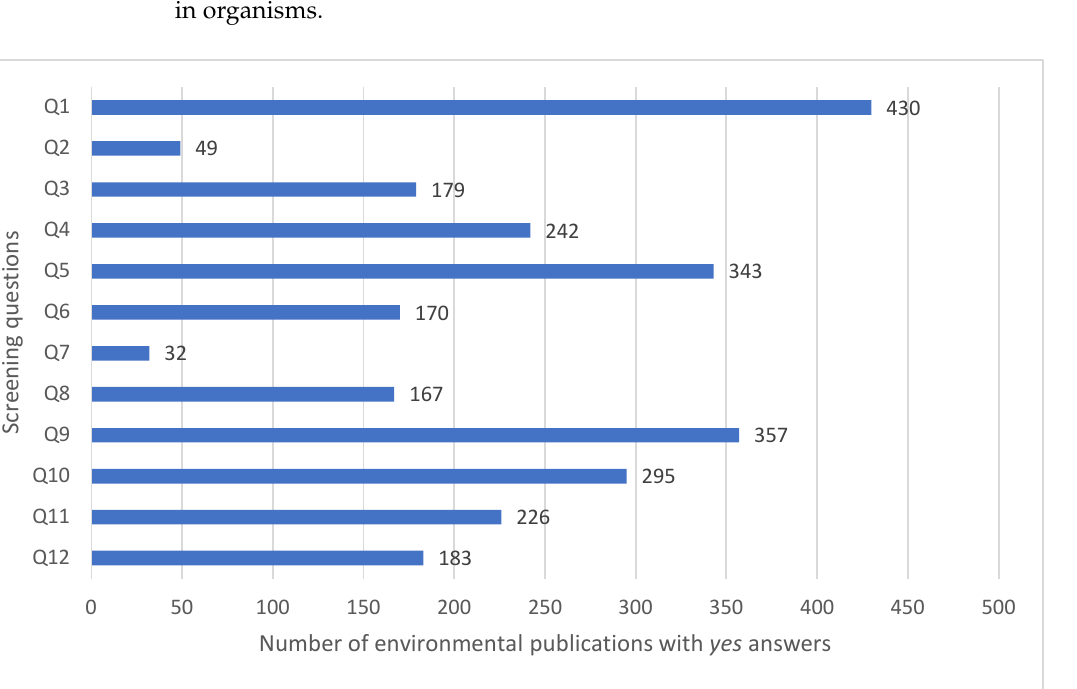
Figure 3. Total literature by category and year for included articles, 2010 – January